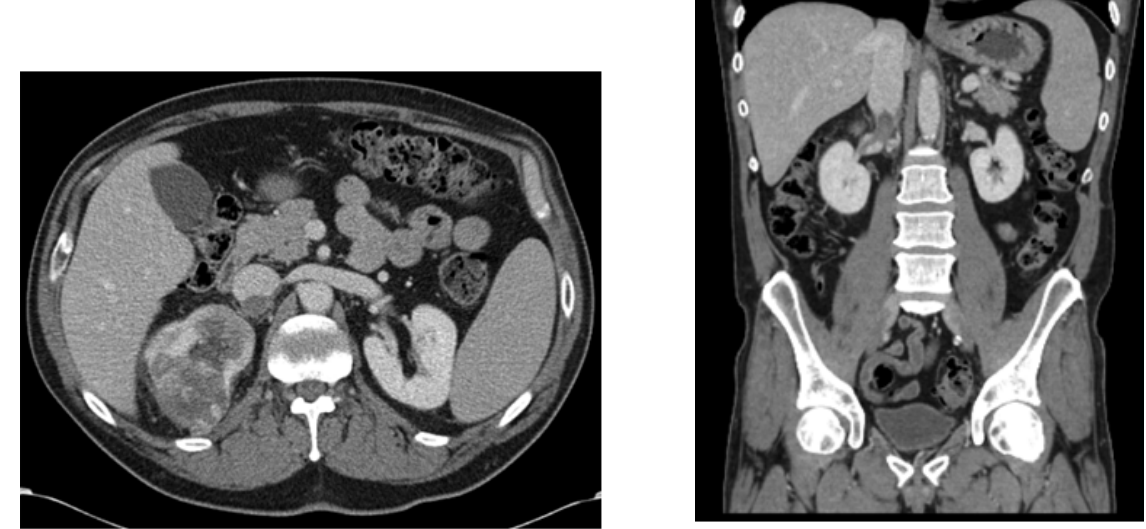
FIGURE 1 . Axial (left) and coronal (right) CT images of the right kidney showing a midportion renal mass and tumor thrombus in the IVC.